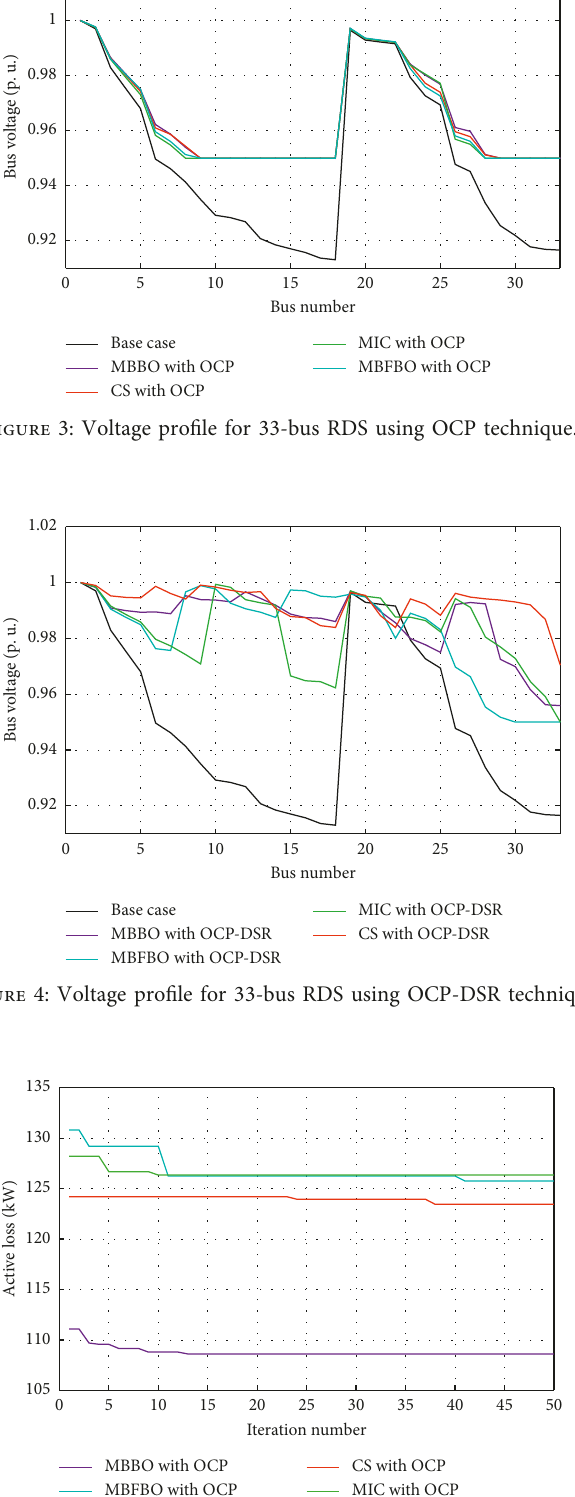
Figure 5: Convergence loss graph for 33-bus RDS using OCP technique.